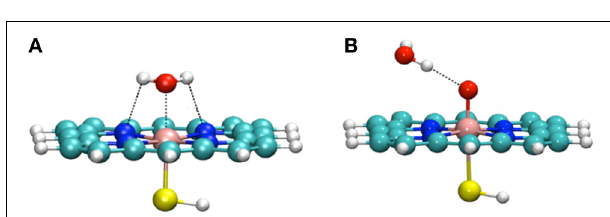
(kcal/mol) obtained at the M06(SCRF)/6-311 + G(d,p) level ( 1 MIC(II)/ 2 MIC(III)), while the values in parentheses are relative energies obtained at the B3LYP(SCRF)/ 6-311 + G(d,p) level. Reprinted from Hirao et al. (2013b).